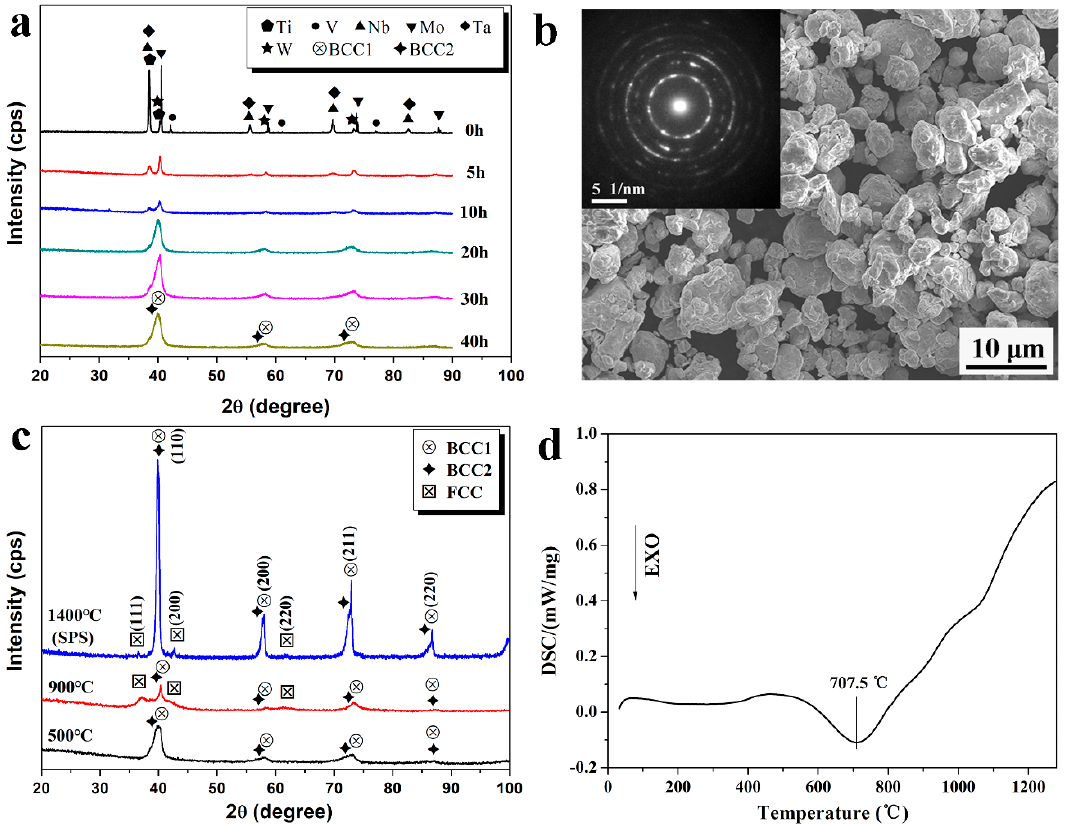
Figure 1. ( a ) XRD patterns of NbMoTaWVTi powders with different milling times; ( b ) SEM image and corresponding SAED pattern of the high entropy alloy (HEA) powders after 40 h of milling; ( c ) XRD patterns of ball milled powders heat-treated at 500 °C, 900 °C for 1 h, and bulk HEA after spark plasma sintering (SPS) at 1400 °C; ( d ) DSC curve of the HEA powders after 40 h of milling.